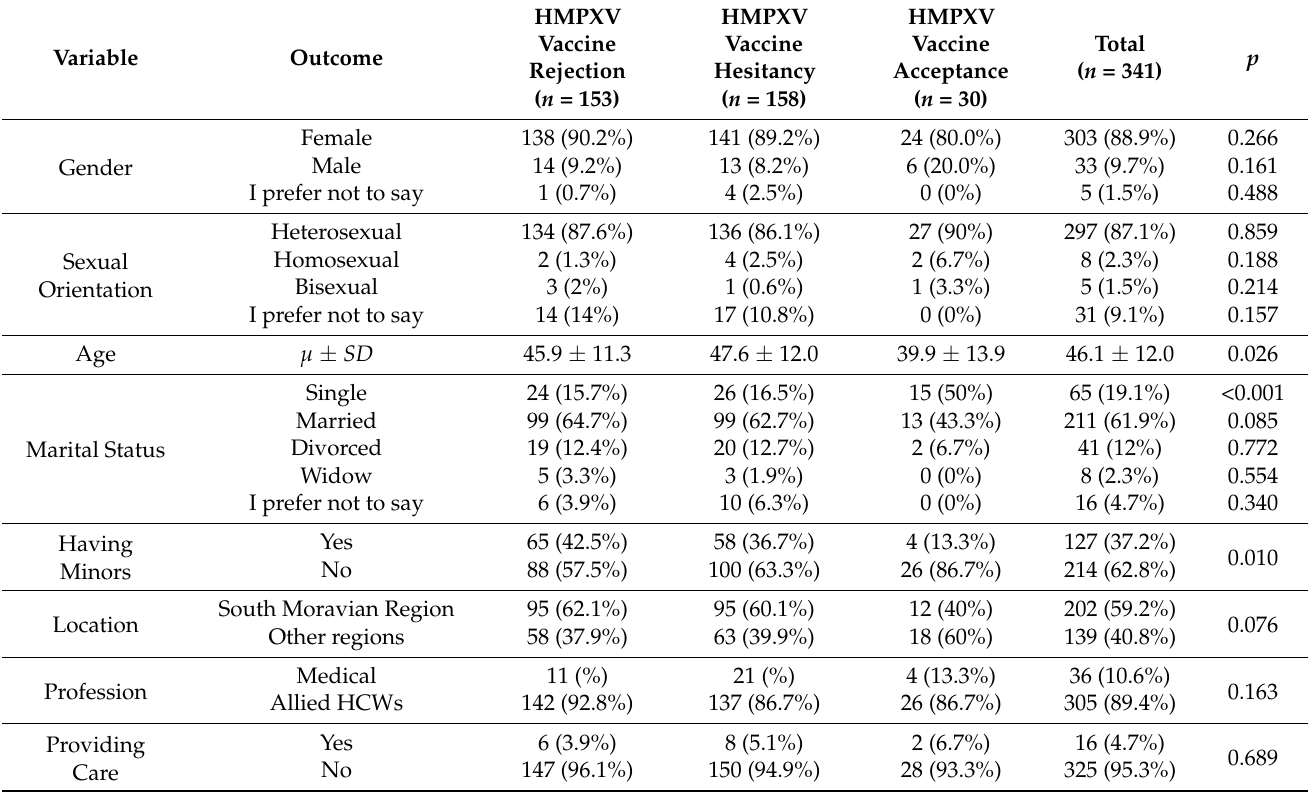
Table 1. Demographic characteristics of Czech HCWs responding to the HMPXV survey, September 2022 ( n =